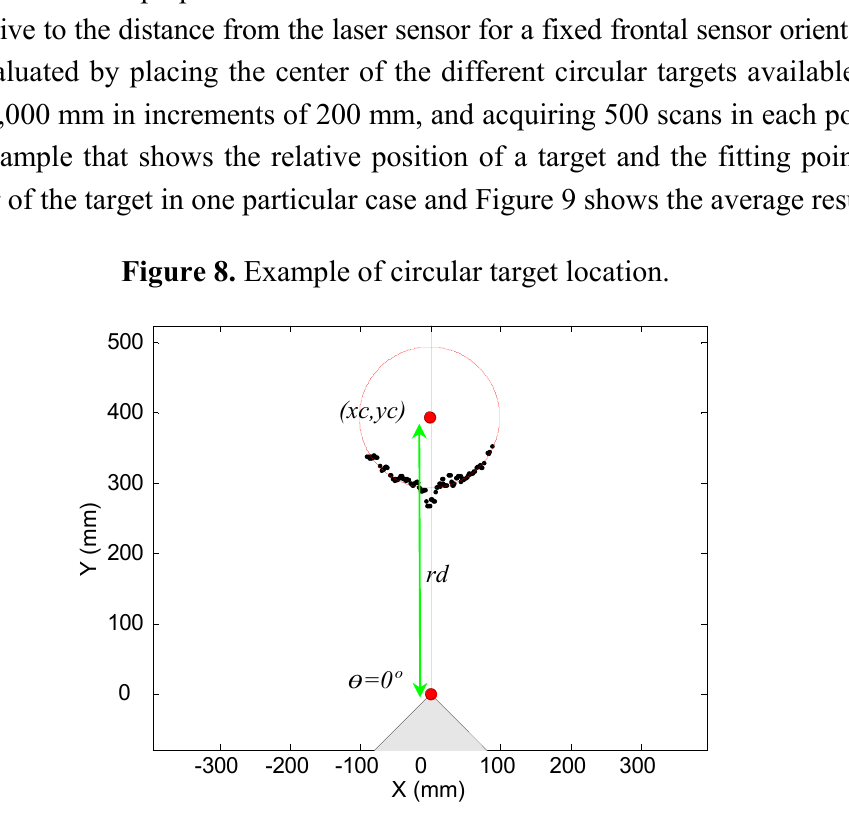
Figure 9. Average error ( a ) and standard deviation ( b ) for different target